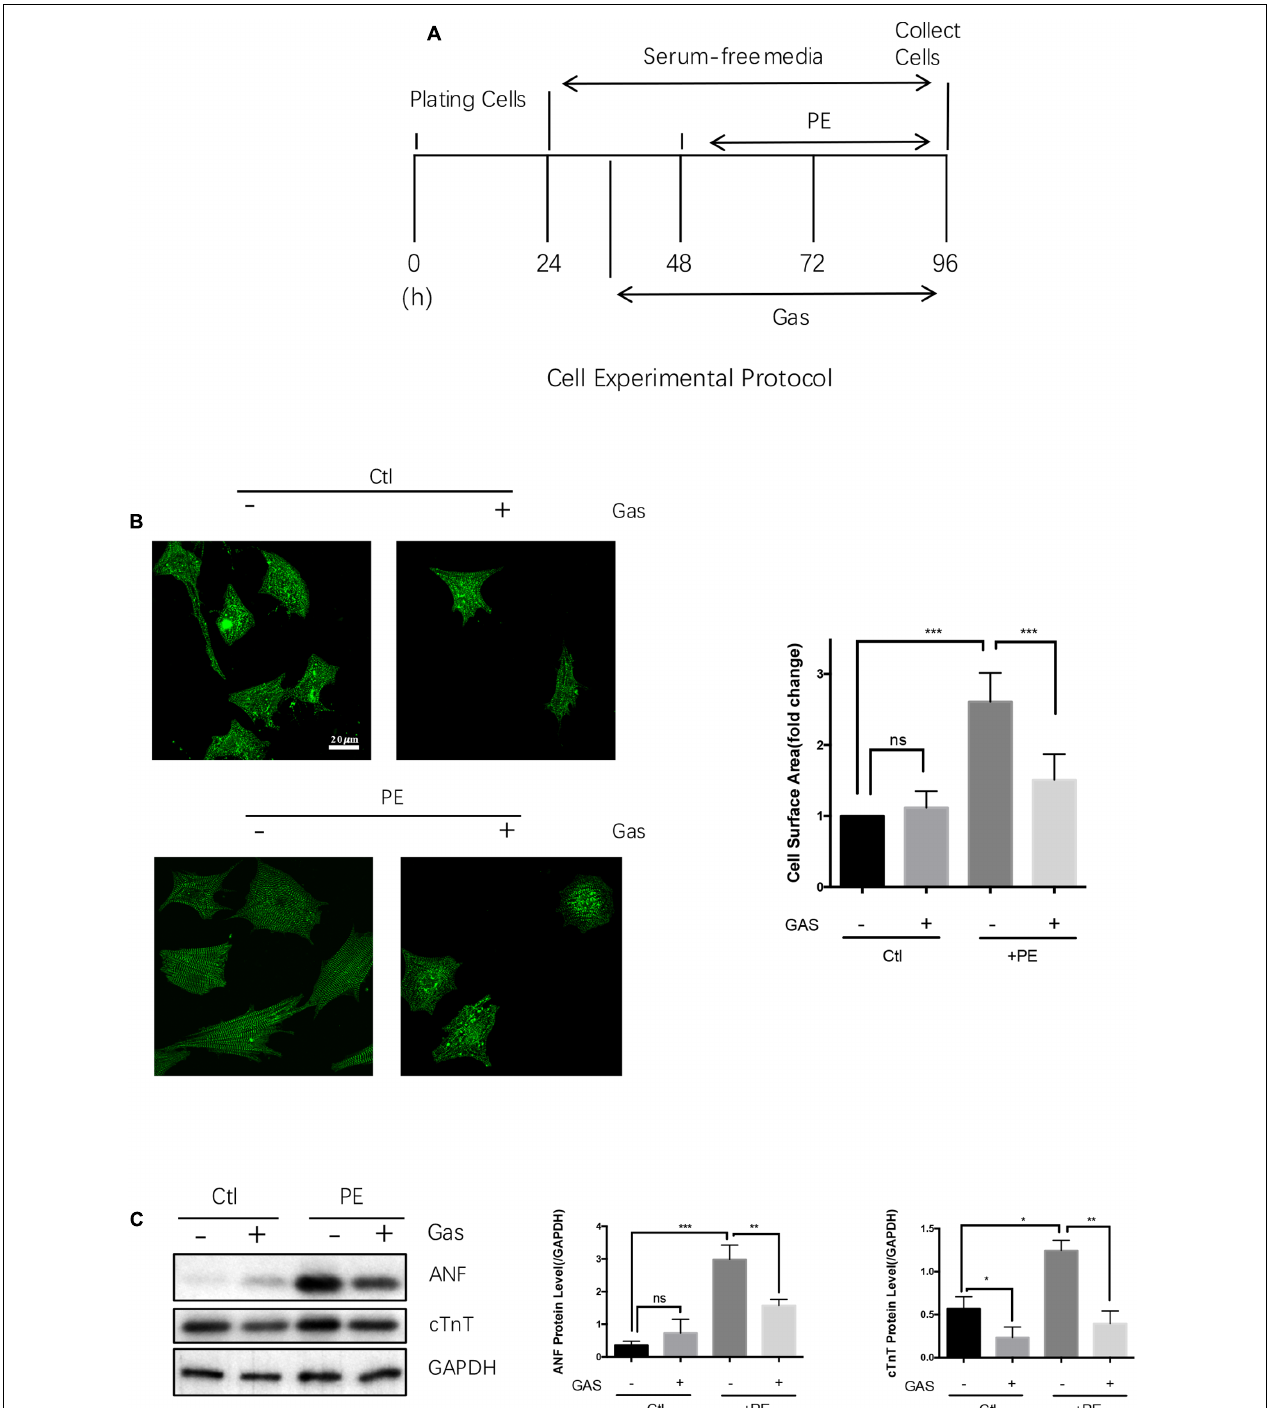
FIGURE 2 | Gastrodin inhibited the PE-induced cardiac hypertrophy in cultured rat neonatal cardiomyocytes. Cultured NRCMs. (A) Shows the schematic experimental protocol. NRCMs were treated with 50 µ mol/L PE for 48 h to induce hypertrophy. GAS at 100 µ mol/L was applied 12 h before PE. (B) Shows the changes in cell surface area with representative images (left) and data summary (right). The cells were stained with anti- α -actinin antibody (green). (C) Shows the changes in ANF and cTnT protein expression with representative images (left) and data summary (right). The data are expressed as the mean ± SEM [ n = 5 repeats, > 50 cells per repeat in (B) ; n = 5 repeats in (A–C) ]. ∗ p < 0.05; ∗∗ p < 0.01; ∗∗∗ p < 0.001. ns, not